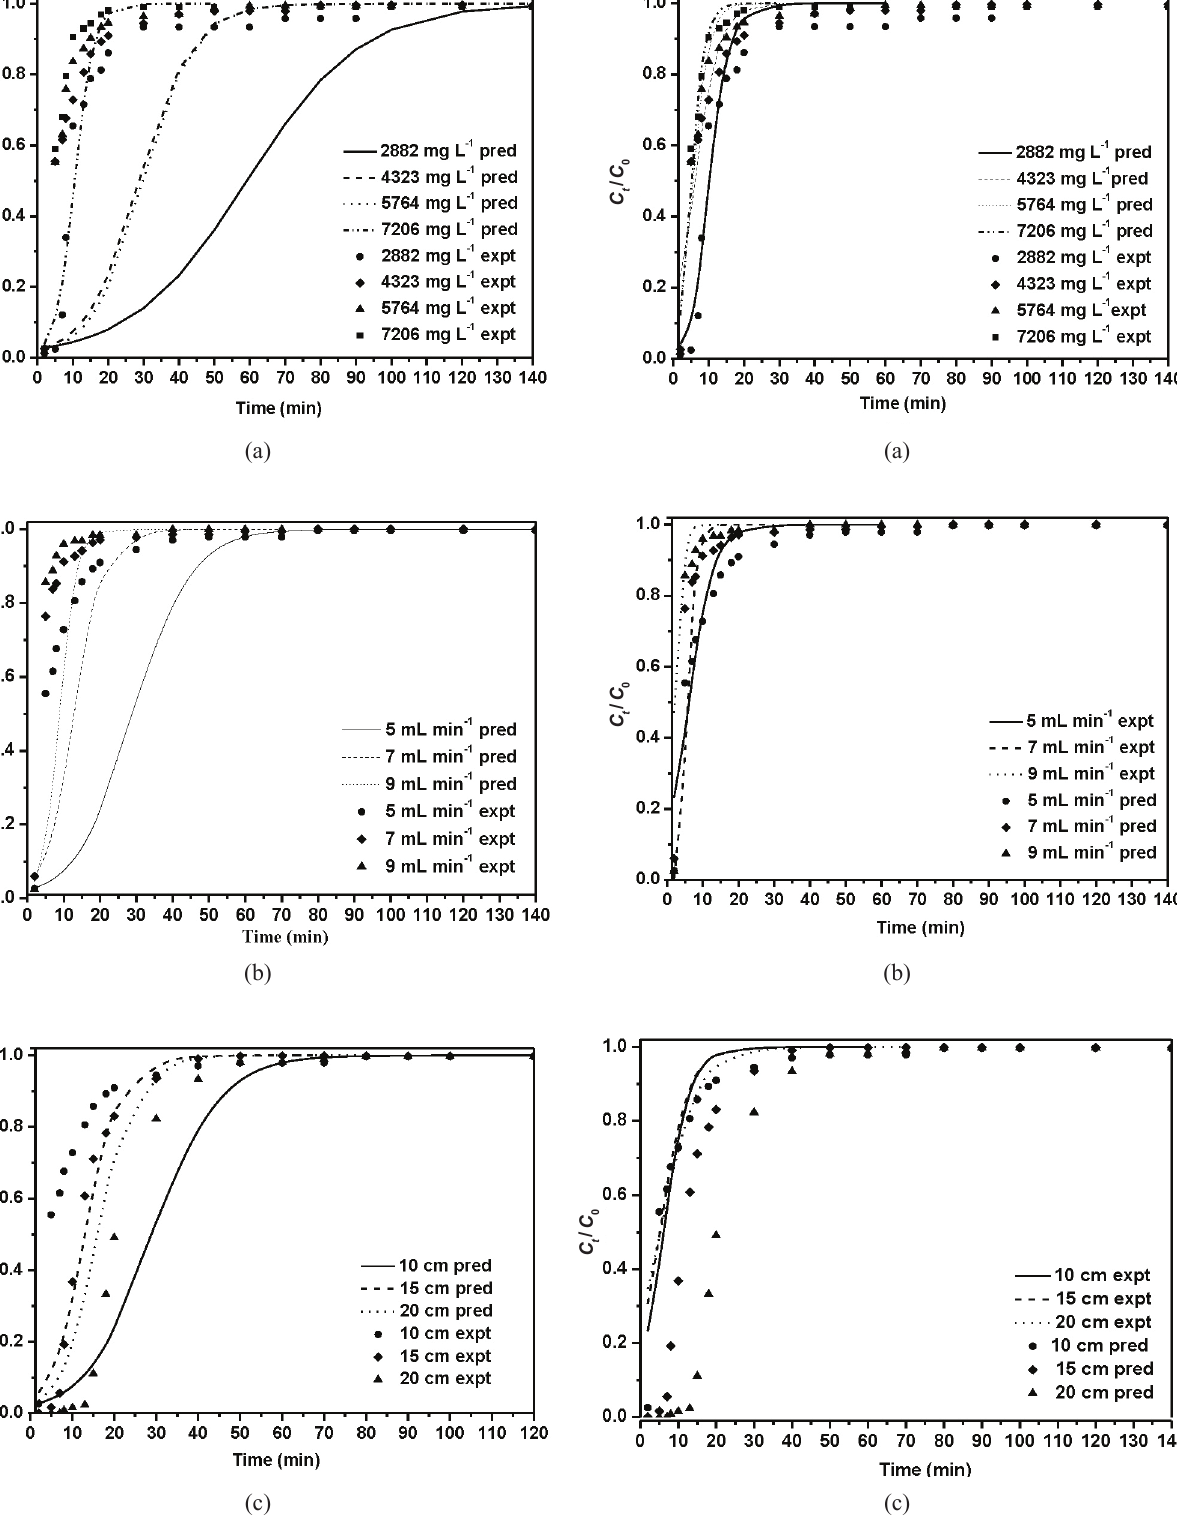
Fig. 7 – Comparison of experimental and predicted break- through curves using Yoon-Nelson model at different (a) influ- ent concentrations, (b) flow rates, and (c) bed heights